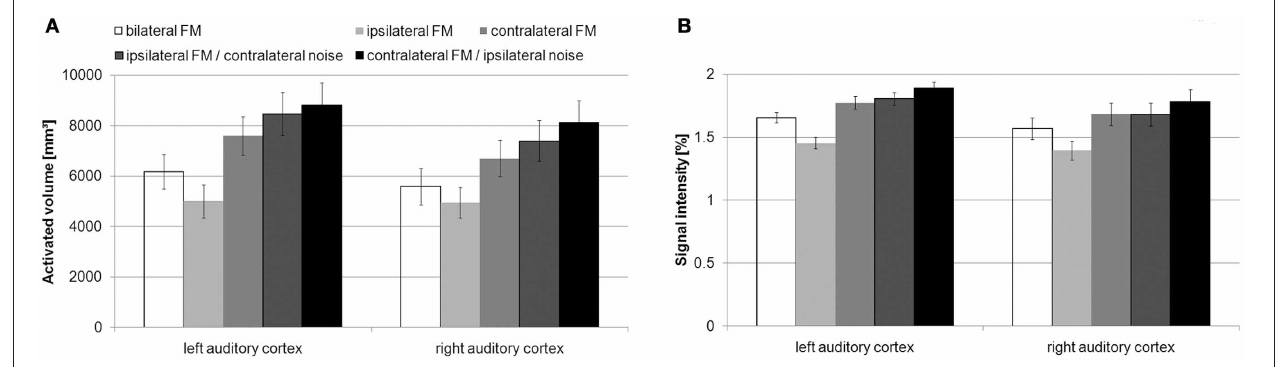
FIGURE 3 | Mean activated volume (A) and mean signal intensity (B) with standard errors within the auditory cortex during the different conditions of presentation. In the conditions without noise, the activated